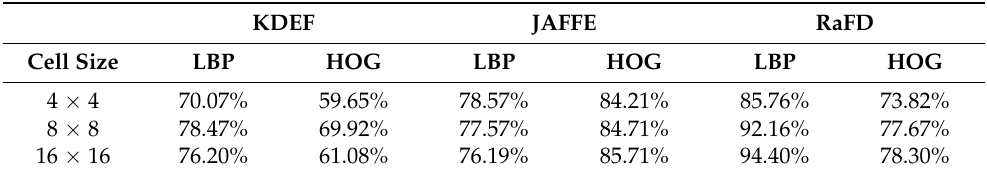
Table 4. Classification accuracy with LBP and HOG methods applied on the images downsized by